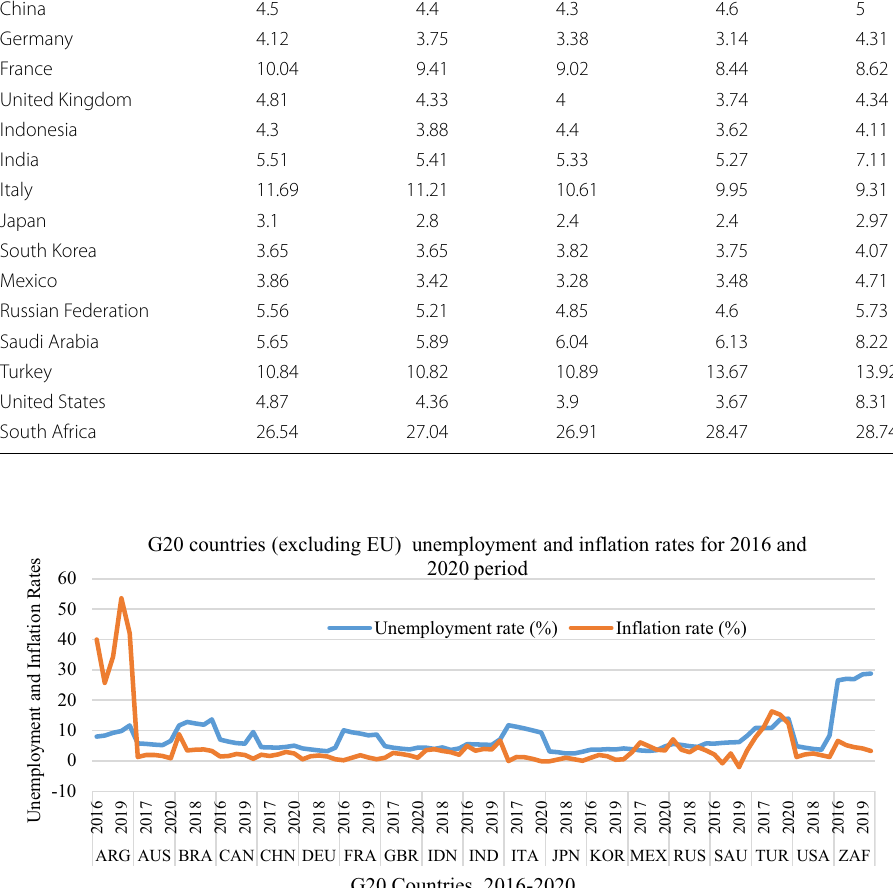
demand shocks. This may ultimately lead to stagnation in economies, as described by higher price levels (revenge pricing) and unemployment rates. Remarkably, the struc- ture and power of the negative relationship rely on several elements, such as inflation with respect to its long-dated tendency, the bottom of its extrinsic impact, and politi- cal action. The current economic situation permits analysis of the inflation, industrial production, GDP, and unemployment dynamics of countries with great alterations in economic factors, as the world started to gear toward policy intervention for economic recovery from the COVID-19 pandemic. Tables 5 and 6 list the unemployment and inflation rates in the G20 countries, except the European Union, from 2016 to 2020. Fig- ure 7 shows the unemployment rates from 2016 to 2020, indicating that inflation has